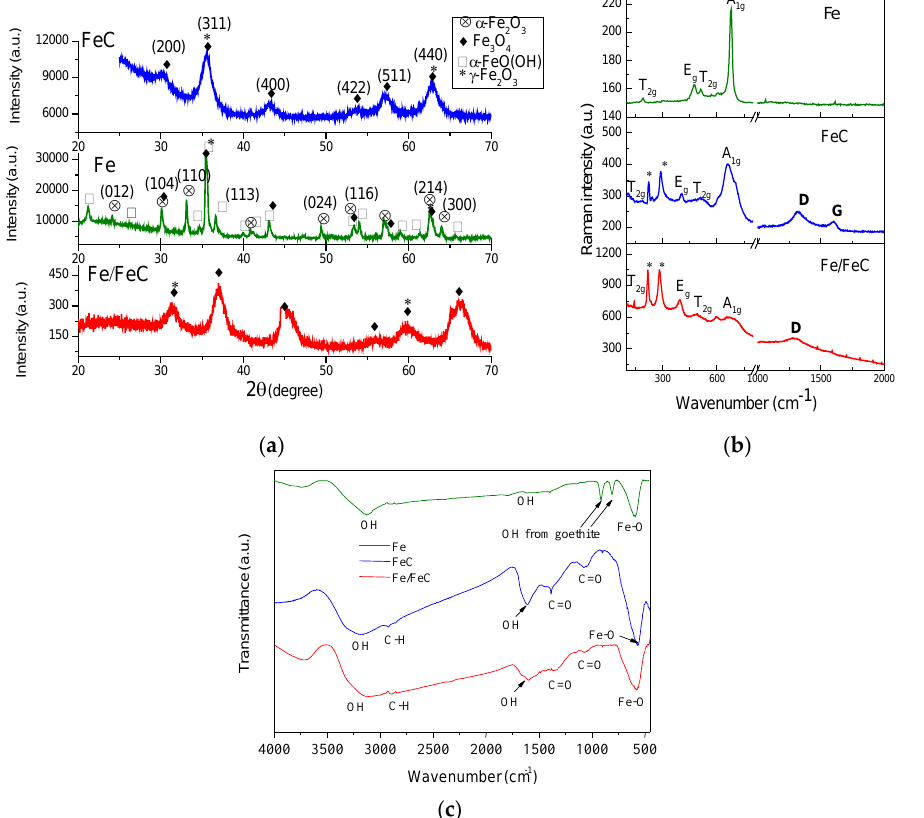
Figure 1. Structural characterizations by ( a ) XRD, ( b ) Raman and ( c ) FTIR measurements. The asterisks mean the presence of the maghemite phase.